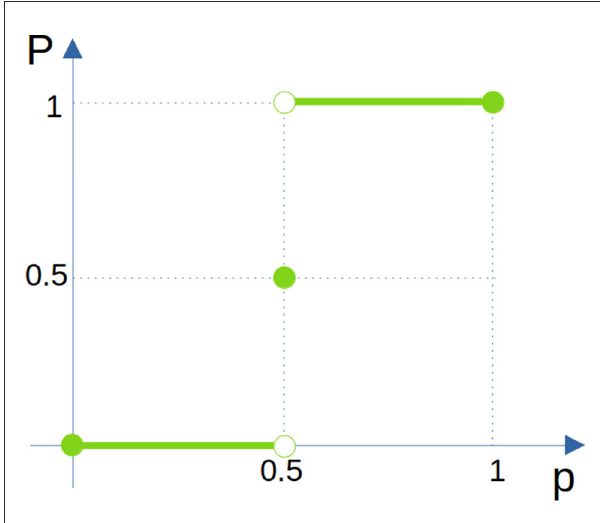
FIGURE3 Different outcomes for P correct for different p intervals when k is going to ∞